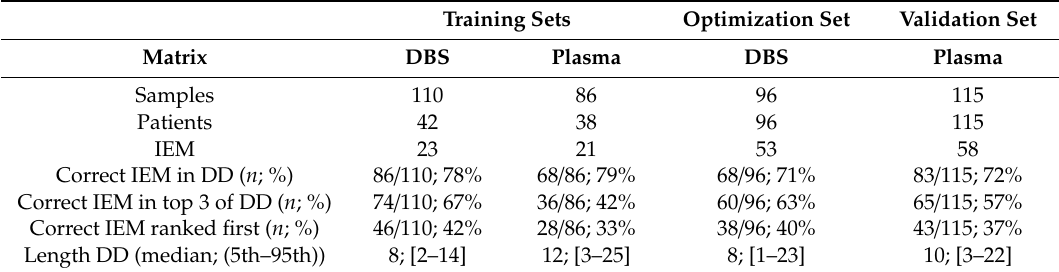
Table 1. Performance automated data interpretation for patient sample